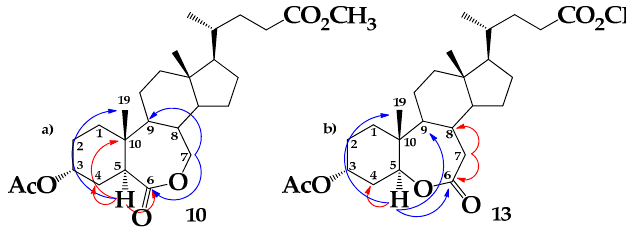
Figure 3. Major observed 2 J HC ( red arrows ) and 3 J HC ( blue arrows ) correlations of hydrogens H-5 α and H-7 for compound 10 (7-oxalactone derivative ( a )) and compound 13 (6-oxolactone derivative ( b )).